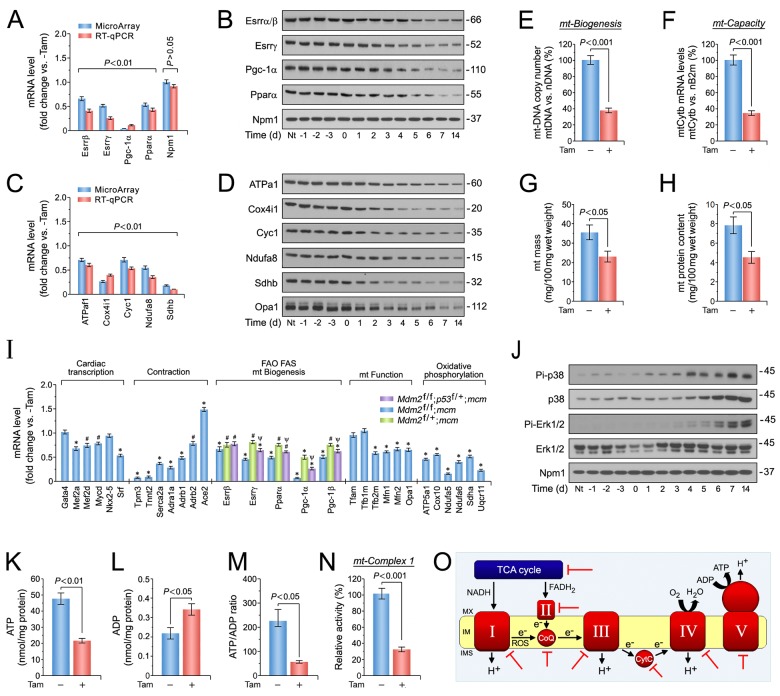
Mdm2 is involved in the maintenance of mitochondrial biogenesis and bioenergetics.(A) Expression levels of selected factors from top-ranked gene sets identified in Fig 4A that play a crucial role in the regulation of mitochondrial function and fatty acid oxidation as analyzed by RT-qPCR. n = 4. Left ventricular tissue samples from Mdm2f/f;mcm mice were analyzed at 7 days post-Tam. (B) Immunoblot analysis of key factors regulating mitochondrial biogenesis and fatty acid oxidation from Mdm2f/f;mcm mice. Western blots were repeated at least once with similar results. (C) Transcript levels of important constituents of the mitochondrial electron transport chain participating in oxidative phosphorylation in Mdm2f/f;mcm mice. n = 4. (D) Immunoblot analysis of important components of the mitochondrial electron transport chain complexes in Mdm2f/f;mcm mice. Western blots were repeated at least once with similar results. (E) Mitochondrial biogenesis, defined as relative DNA copy number of mitochondrial encoded Cytb gene normalized to the copy number of the nuclear gene B2m, was determined by qPCR in Mdm2f/f;mcm mice. n = 4. (F) Mitochondrial capacity, defined as relative mRNA levels of the nuclear gene cytochrome b (Cytb), a constituent of oxidative phosphorylation (OxPhos) complex III, normalized to B2m transcript expression, was determined by RT-qPCR in Mdm2f/f;mcm mice. (G) Decreased mitochondrial wet weight in ventricular tissue of Mdm2f/f;mcm mice post-Tam. n = 4. (H) Downregulation of total mitochondrial protein content in Mdm2-deficient ventricles. n = 4. (I) Cardiac-specific gene expression in the indicated Mdm2 and p53 mutant mice post-Tam as analyzed by RT-qPCR. n = 4. *P < 0.01 vs. -Tam. #P < 0.05 vs. -Tam. Ψ < 0.05 vs. Mdm2f/+;mcm and Mdm2f/f;mcm. (J) Activation of p38 and Erk1/2 signal transduction pathways is associated with the development of decompensated cardiac hypertrophy in Mdm2f/f;mcm mice exposed to Tam. LV extracts were prepared at the indicated time points, and were immunoblotted with the antibodies as indicated on the left. The amount of phosphorylation was determined using phosphorylation site-specific antibodies to p38 and Erk1/2. Western blots were repeated at least once with similar results. (K) Markedly impaired ATP production indicates mitochondrial dysfunction in Mdm2f/f;mcm mice post-Tam. ATP levels were analyzed with a bioluminescence-based assay. n = 4. (L) Acute genetic deletion of Mdm2 evokes increases in ADP levels in Mdm2f/f;mcm mice post-Tam. n = 4. (M) Mdm2 is indispensable for the maintenance of proper energy metabolism as indicated by a significantly lower ATP/ADP ratio in Mdm2f/f;mcm mice post-Tam. n = 4. (N) Mitochondrial complex I activity in Mdm2f/f;mcm mice was determined with an ELISA assay employing isolated mitochondria and complex I-specific antibodies. The NADH dehydrogenase activity of complex I was determined colorimetrical by monitoring the oxidation of NADH to NAD+. n = 4. (O) Potential Mdm2-regulated genes in a well-established mt interaction network. Red block arrows indicate significantly downregulated genes in Mdm2f/f;mcm mice post-Tam. CoQ, coenzyme Q10. CytC, cytochrome c. IMM, inner mt membrane. IMS, inner membrane space. MMX, mt matrix. ROS, reactive oxygen species. (A to M) Tam- and vehicle-injected Mdm2f/f;mcm animals were investigated. Unless indicated otherwise left ventricular samples from 12-week-old mice were analyzed at 7 days post-Tam. Fig 6 data are means±s.e.m.